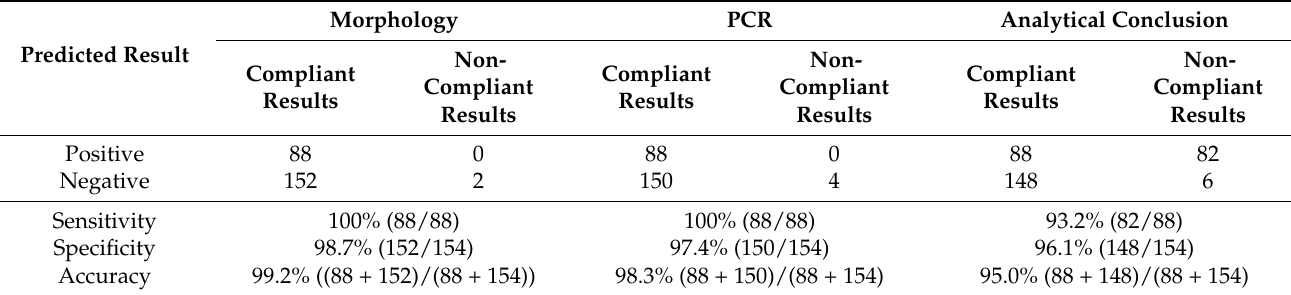
Table 4. Overall performance of the official laboratory